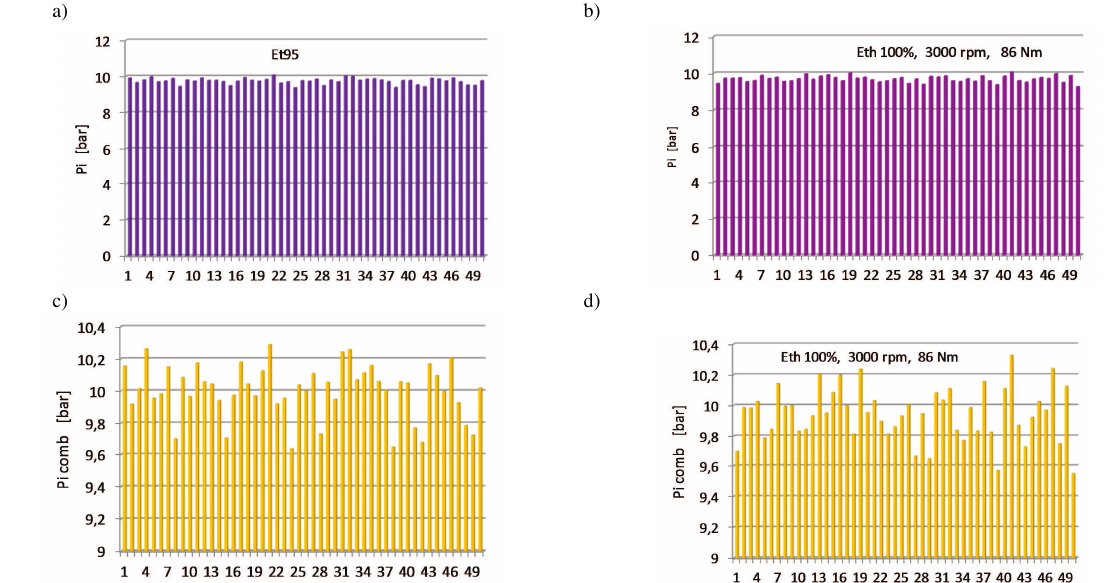
Fig. 8. Comparison of changes of mean indication pressure of complete cycle of p i and high pressure portion of the cycle p i comb in the Fiat 1100 MPI run on Et 95 gasoline and Eth 100% ethylene